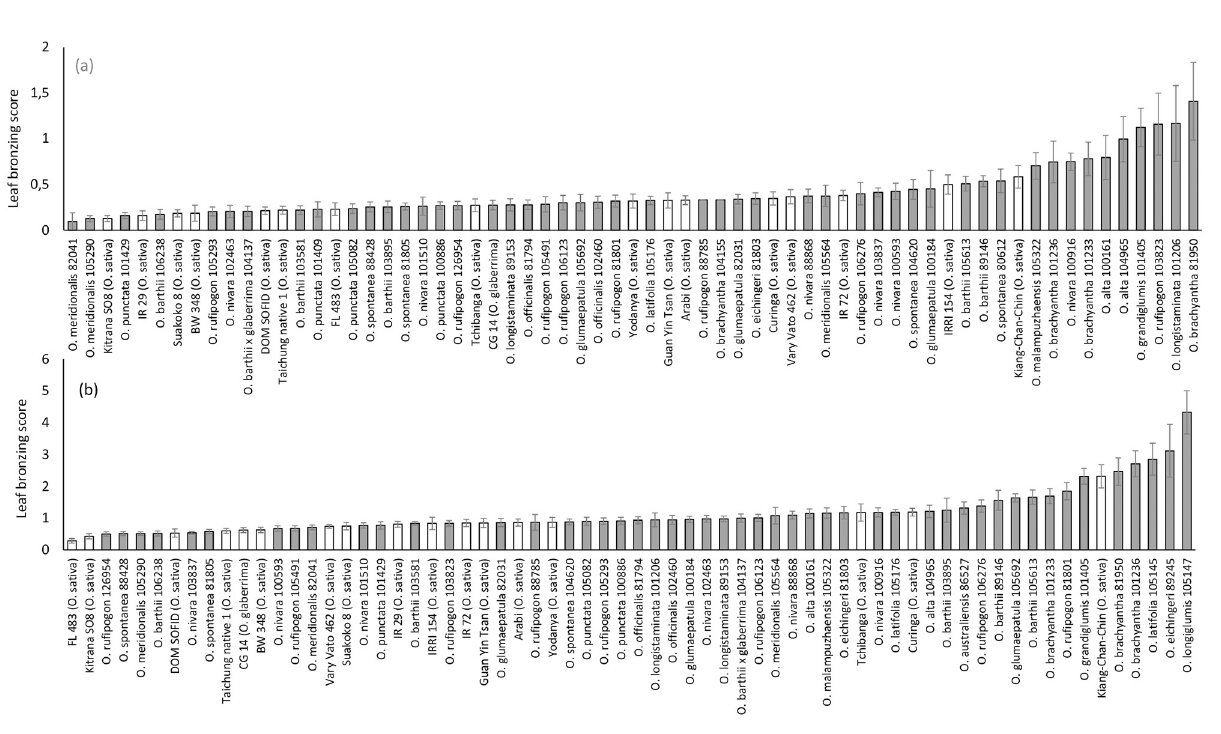
These had previously been described as Fe tolerant i . e . FL483 [26] and Kitrana 508 [32]. Aver- age symptom level in chronic stress was slightly but significantly higher in the group of RWR compared to domesticated rice, and the range and coefficient of variation (CV) of LBS were higher in RWR in both stress conditions, indicating higher variability (S2 Table). At 16 WAT, contrasting RWR and Oryza sativa varieties were selected for analyses of foliar Fe concentrations based on LBS, in order to represent tolerant or sensitive accession either in